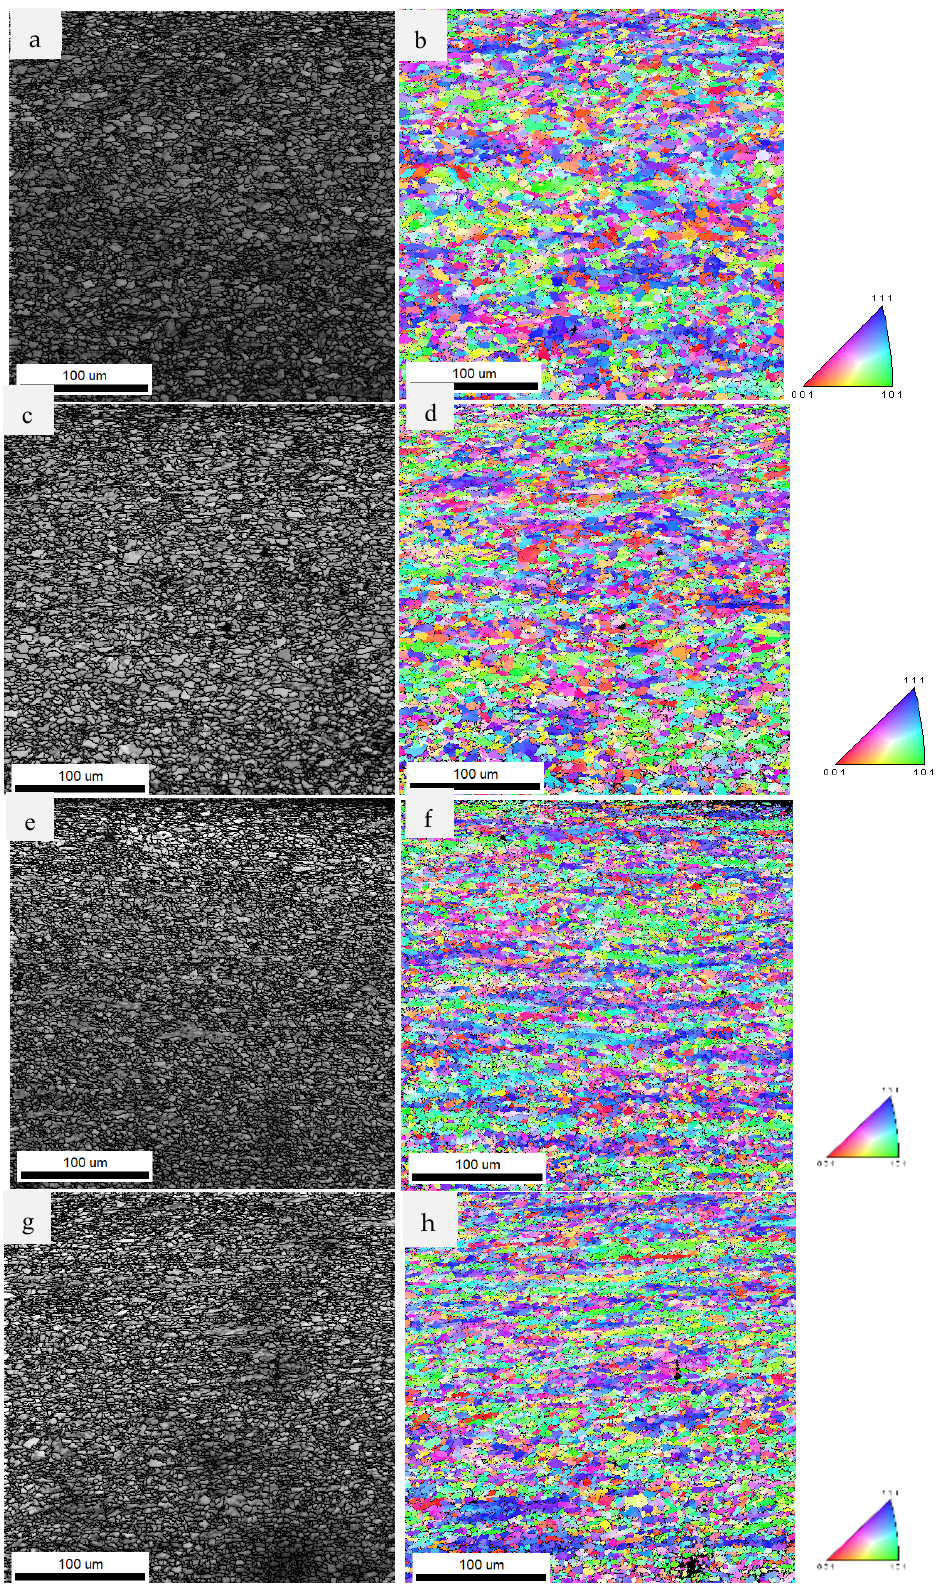
Figure 5. IQ and IPF mapping of LSPwC microalloyed steel at 1064 nm with ( a , b ) 3 GW/cm 2 , ( c , d ) 6 GW/cm 2 , ( e , f ) 9 GW/cm 2 , and ( g , h ) 12 GW/cm.